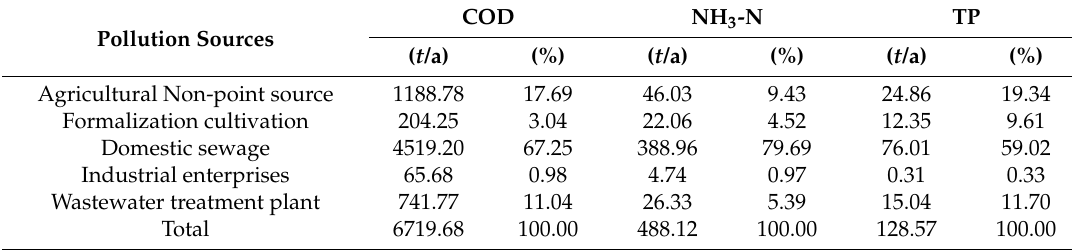
Table 1. The contamination loads and proportion of pollution sources into the